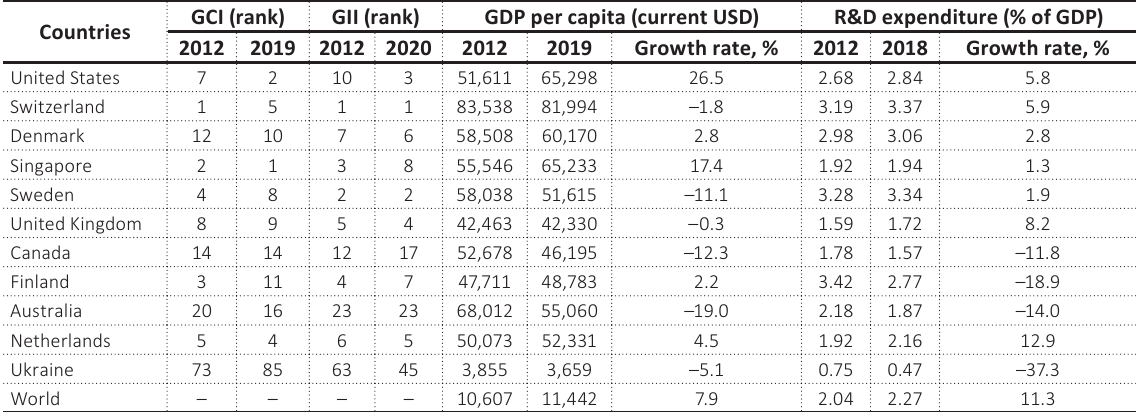
Table 5. Economic development indicators for the sample